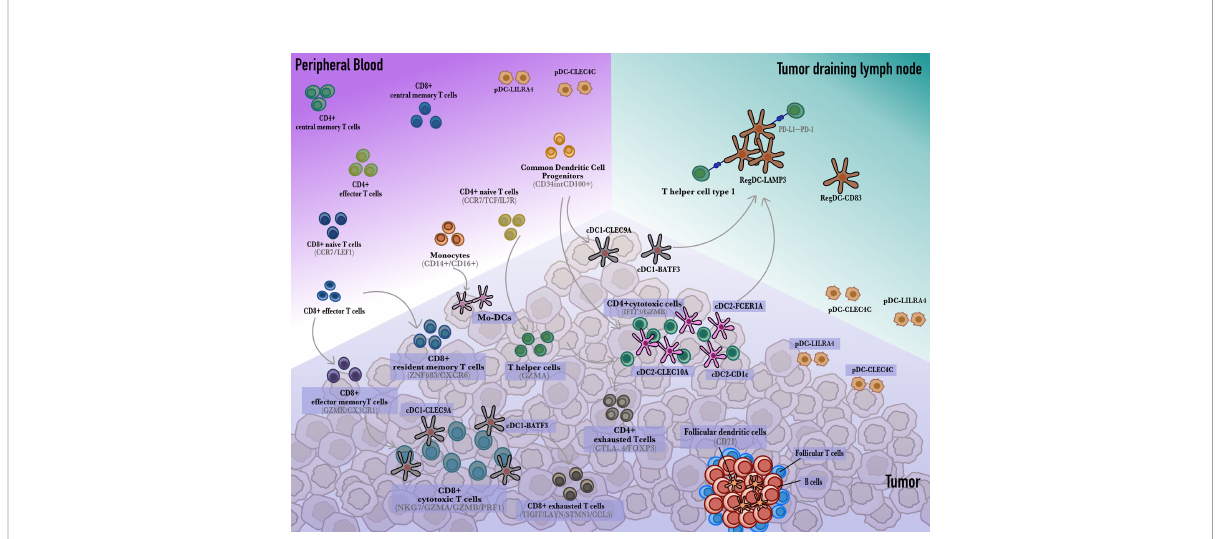
FIGURE 1 The developmental trajectory of dendritic cells and T cells. Monocytes circulate in the peripheral blood and differentiate into dendritic cells that sample and cargo tumor antigens. In the tumor draining lymph nodes, dendritic cells present antigens to CD4 + or CD8 + T cells to activate them into cytotoxic T cells. Additionally, cDCs also interact with resident CD8 + T cells to develop into CD8 + cytotoxic T cells. Besides, cDC1s and cDC2s give rise to regulatory LAMP3 + DC which induce CD8 + T cells exhaustion through the PD-L1-PD-1